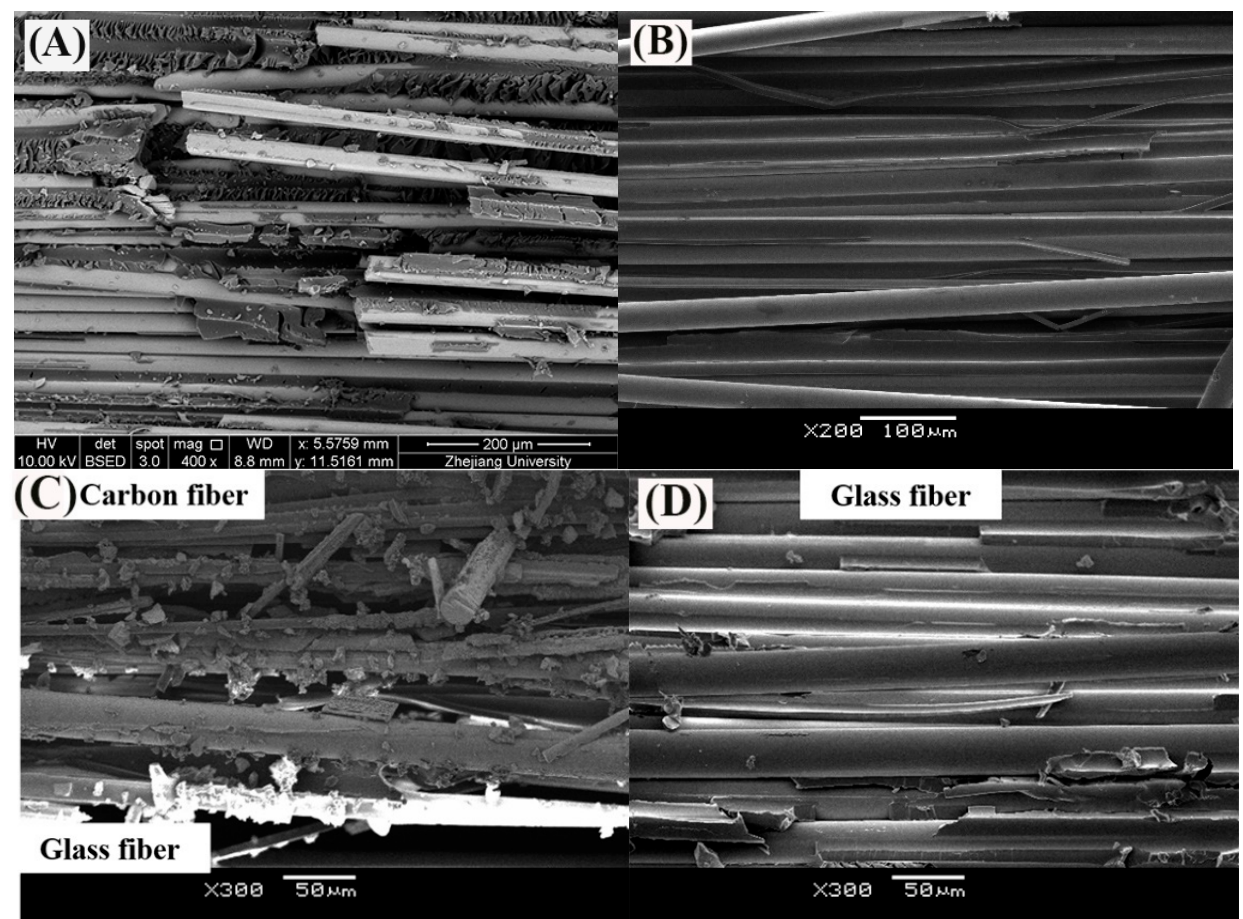
Figure 14. The SEM images of fracture surface of ( A ) GFRP bar at 60 ◦ C in water [31], ( B ) GFRP bar at 60 ◦ C in alkaline solution, ( C ) carbon fiber coat of HFRP bar at 60 ◦ C in alkaline solution and ( D ) GFRP close to the CFRP/GFRP interface of HFRP bar at 60 ◦ C in alkaline solution